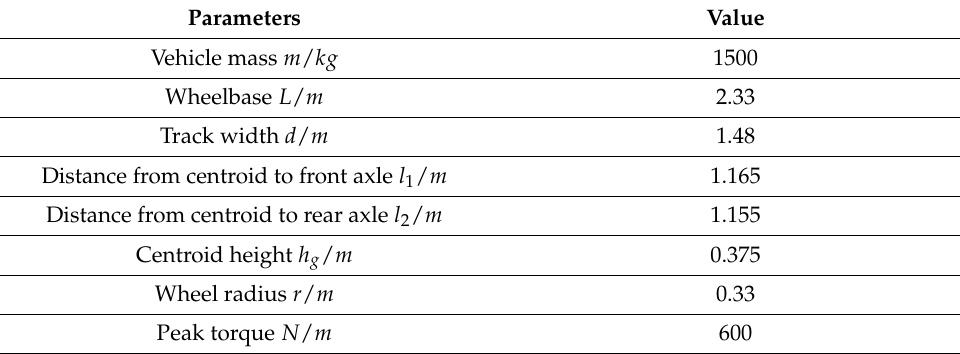
Table 1. Basic parameters of the whole